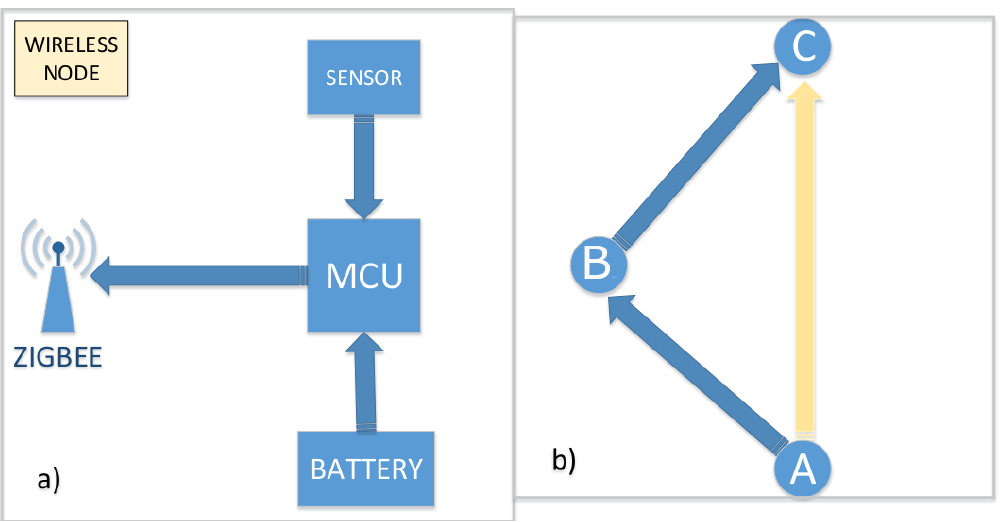
Figure 1. ( a ) Wireless node components. ( b ) Cooperative communication